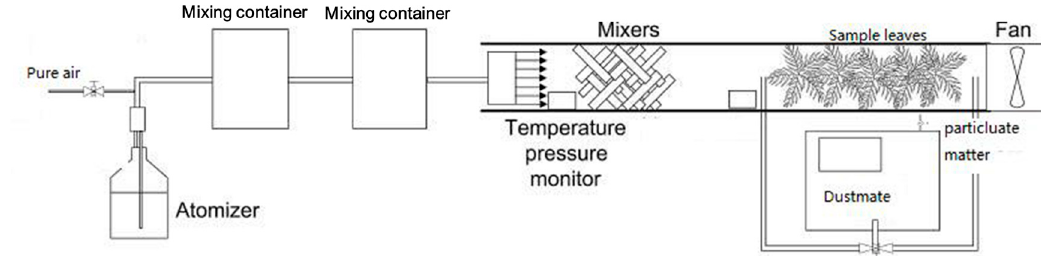
Figure 5. A sketch of the wind tunnel experimental setup [41].